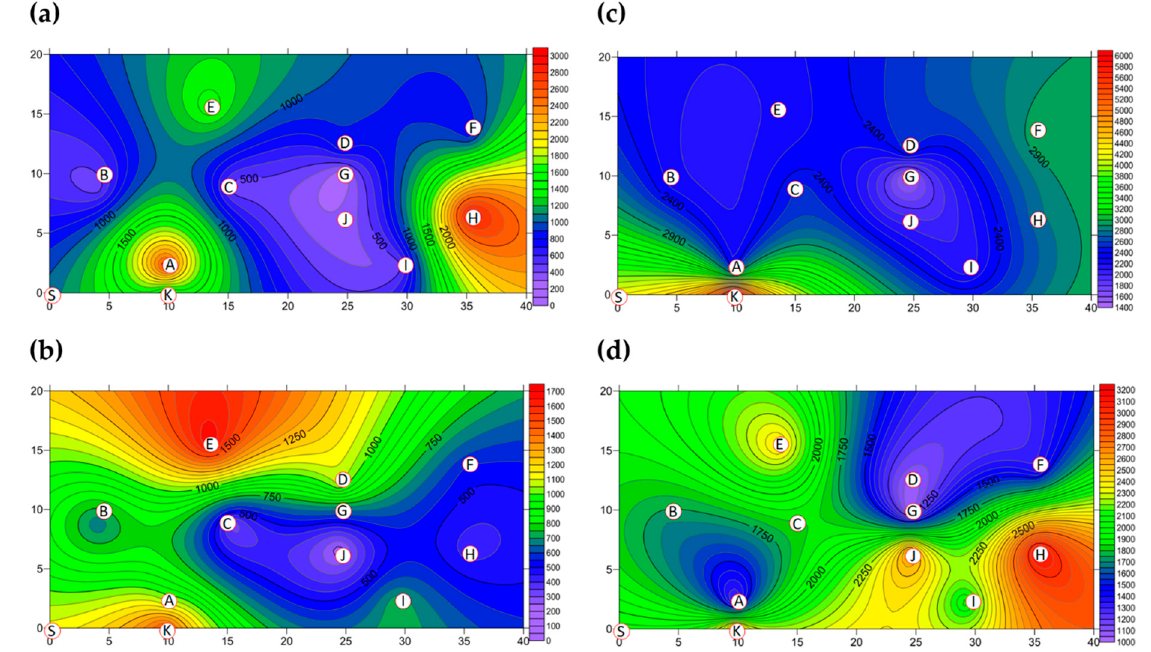
Figure 4. The concentration (CFU m − 3 ) of total BBs present in Market B ( a ) before operations commenced and ( b ) after operations had finished; the total FB concentration in Market B ( c ) before operations commenced and ( d ) after operations had finished. Red circular dots with English titles show sampling locations.